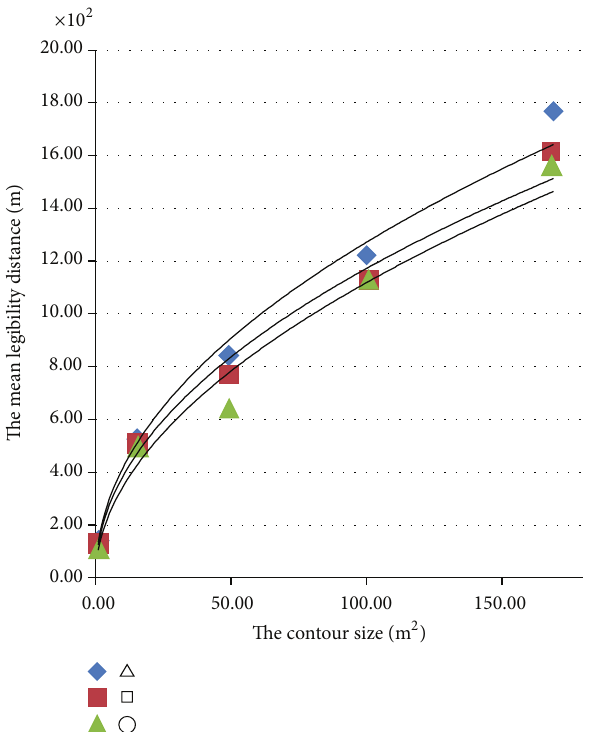
Figure 4: Relationship between the mean legibility distance and the contour size under 60km/h, where the relationship between the mean legibility distance and the contour size under 60km/h was for triangle: 𝑦 = 135𝑥 0.486 and 𝑅 2 = 0.907 , and for round: 𝑦 = 105𝑥 0.513 and 𝑅 2 = 0.908 . 𝑥 represents the size of the roadside object, unit is square meters, 𝑦 represents the mean legibility distance, unit is meter, and 𝑅 2 represents the degree of fitting, describing how well it fits a